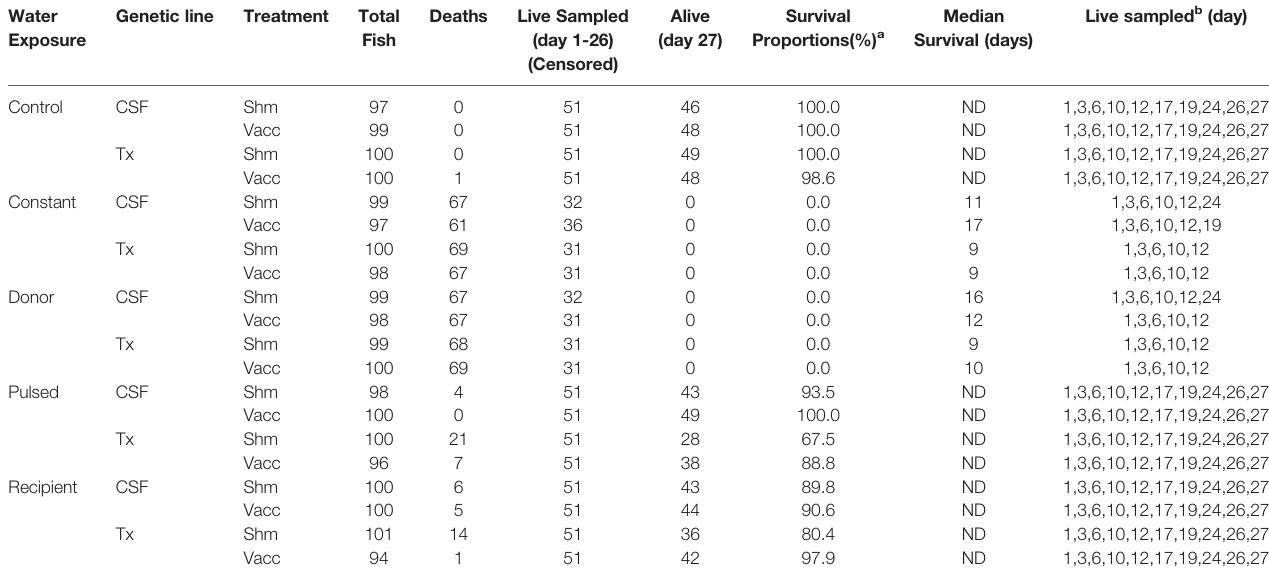
TABLE 1 | Mortality, sampling, and survival proportion of fi sh in 28-day fi eld experiment (including day -1). Water Genetic line Exposure